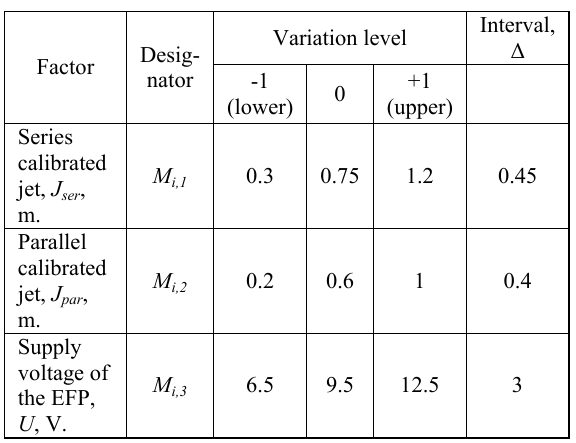
Table 1. Levels and intervals of factor